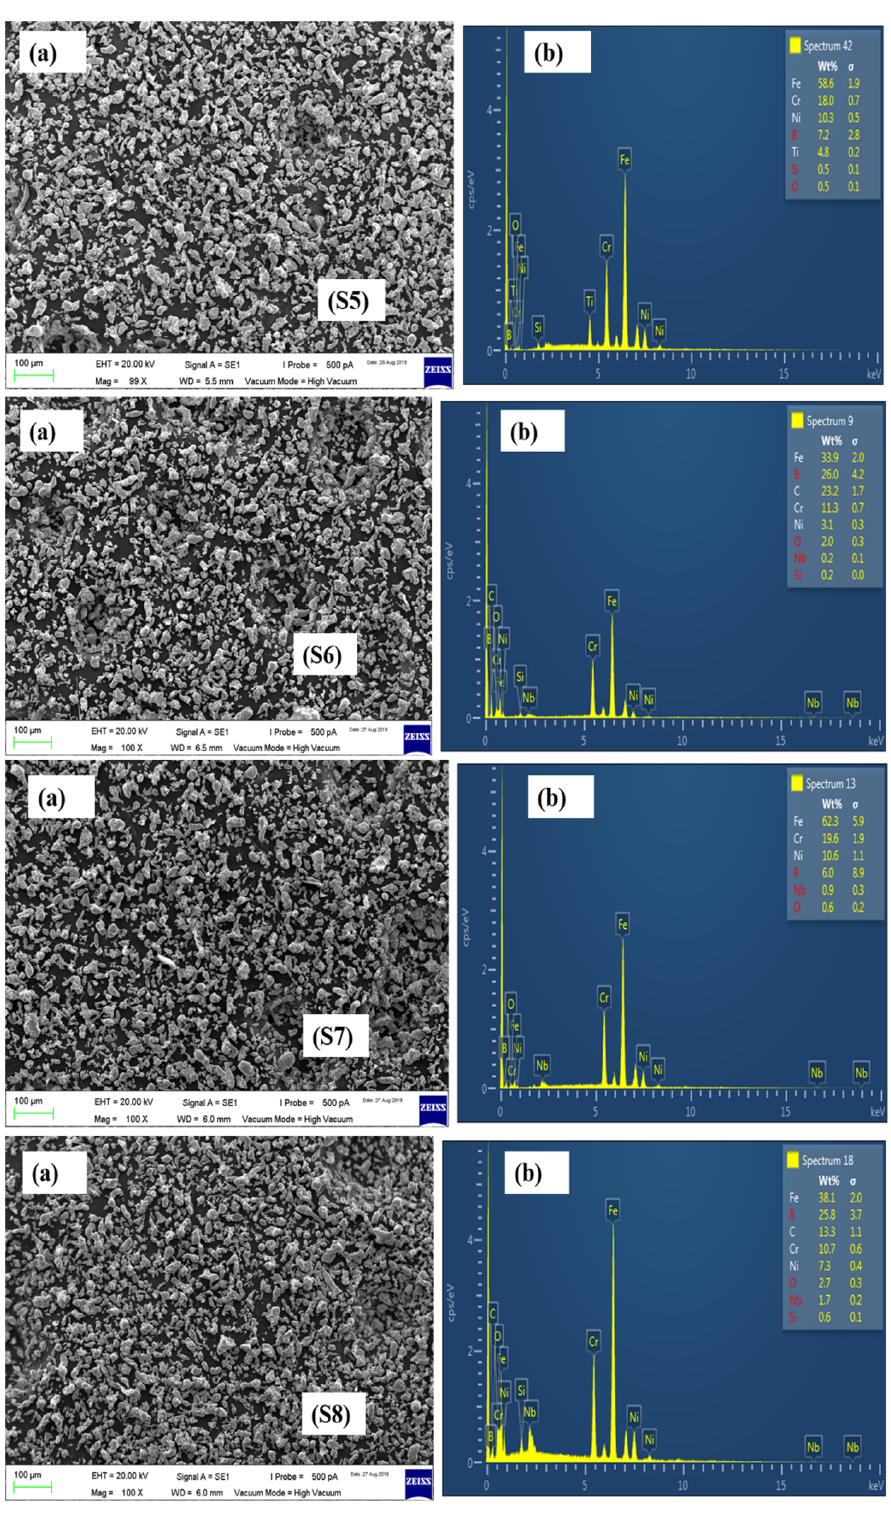
Figure 6. SEM images of S5, S6, S7, and S8 powder formulations.